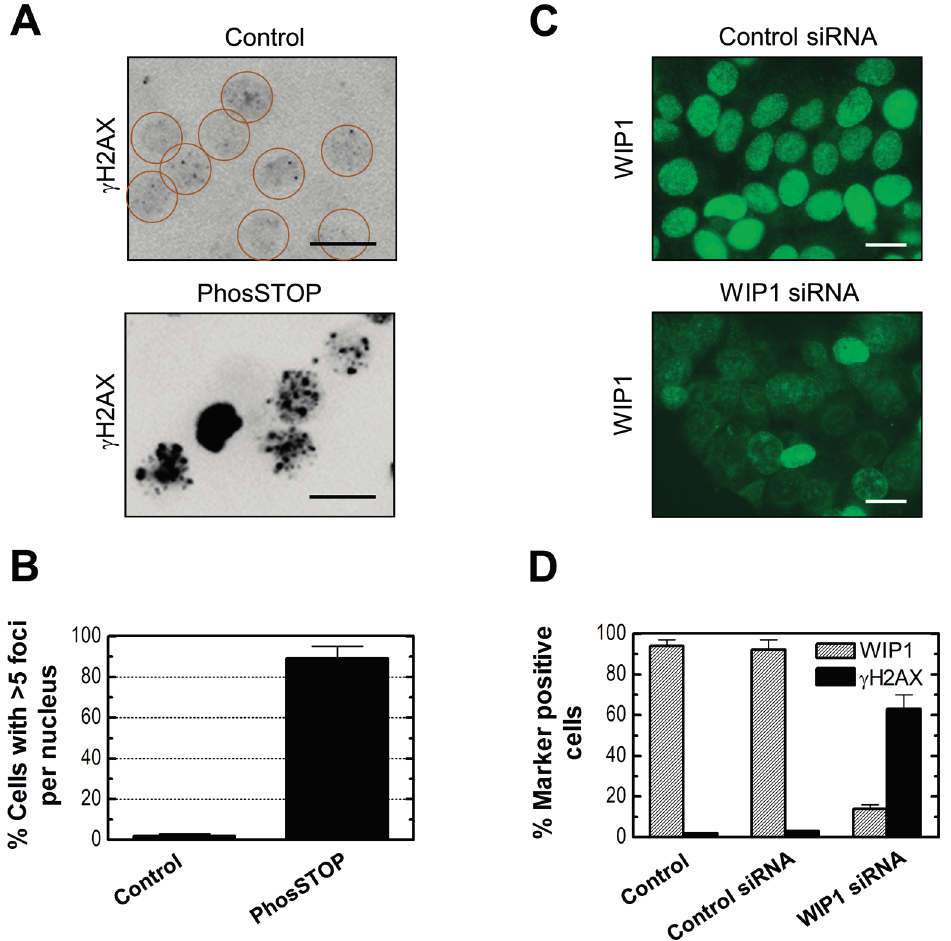
Figure 9. Influence of phosphatase inhibition by PhosSTOP or WIP1 siRNA on γ H2AX foci in MCF7 cells. ( A ) Representative images showing presence of γ H2AX foci after PhosSTOP treatment. Circles mark cells with low (background) levels of foci; Scale bar, 10 µm; ( B ) Proportion of cells with >5 γ H2AX foci/nucleus for the indicated treatments. Bars, SE; ( C ) Representative images showing nuclear WIP1 levels after transfection with control siRNA or WIP1 siRNA; Scale bar, 10 µm; ( D ) Influence of transfection with